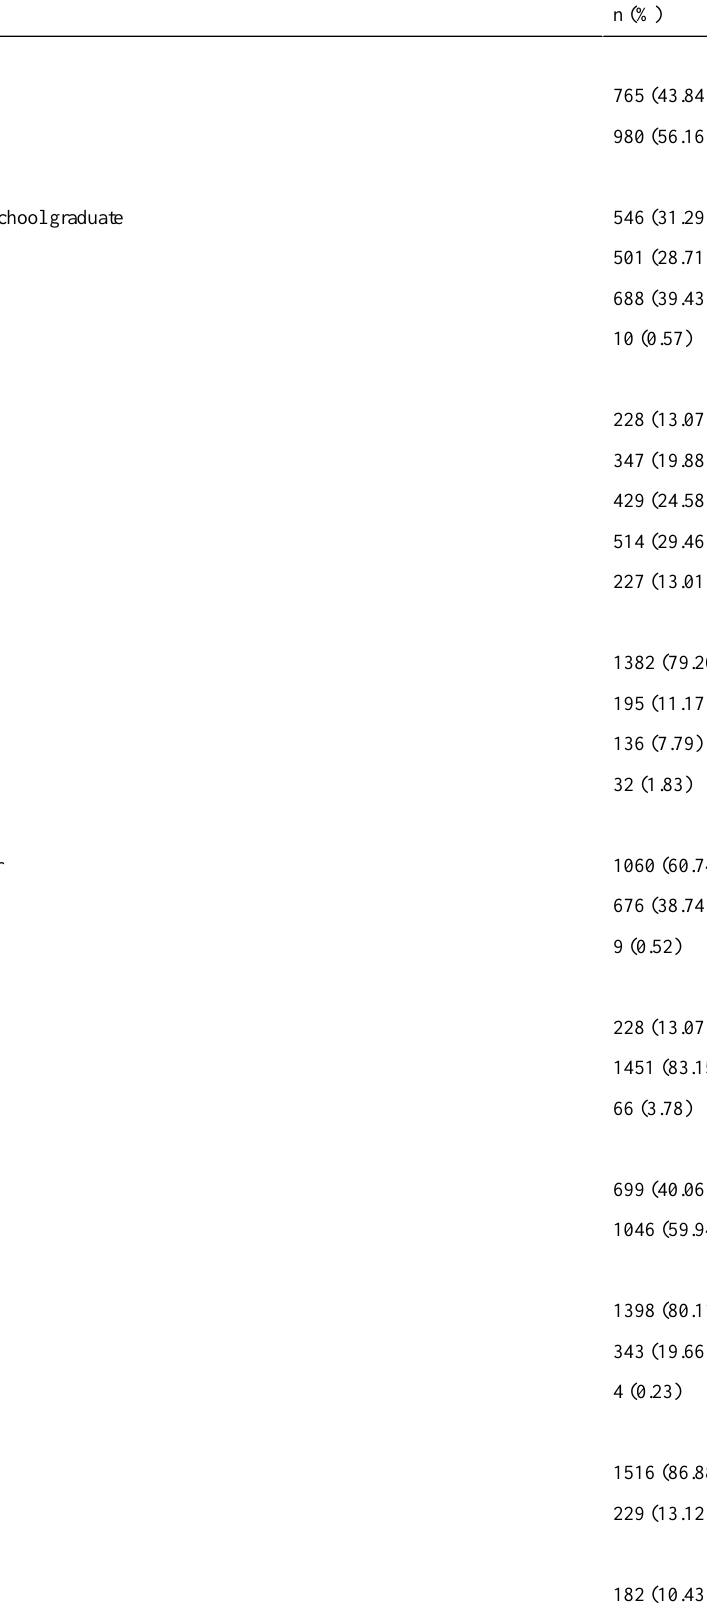
Table 1. Sample characteristics